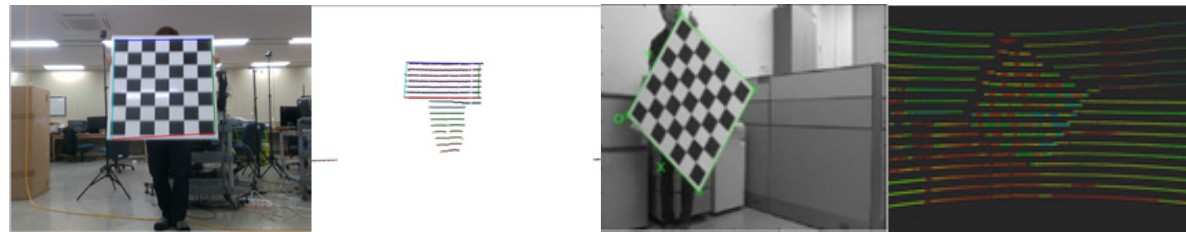
Figure 9. Examples of images and 3D LiDAR data.